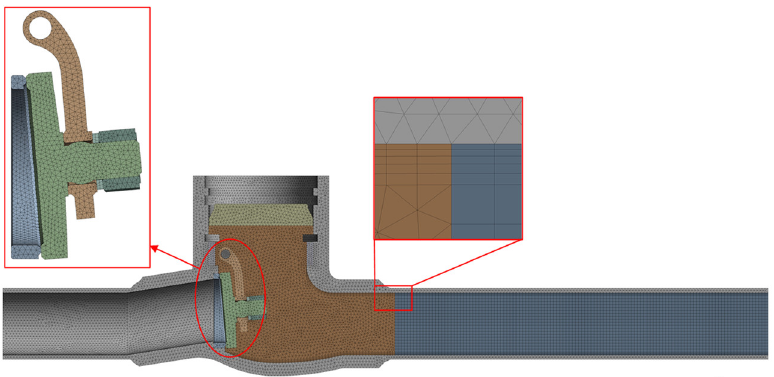
Figure 12. Mesh model of fluid and structure for thermal–fluid–mechanical coupling calculations.